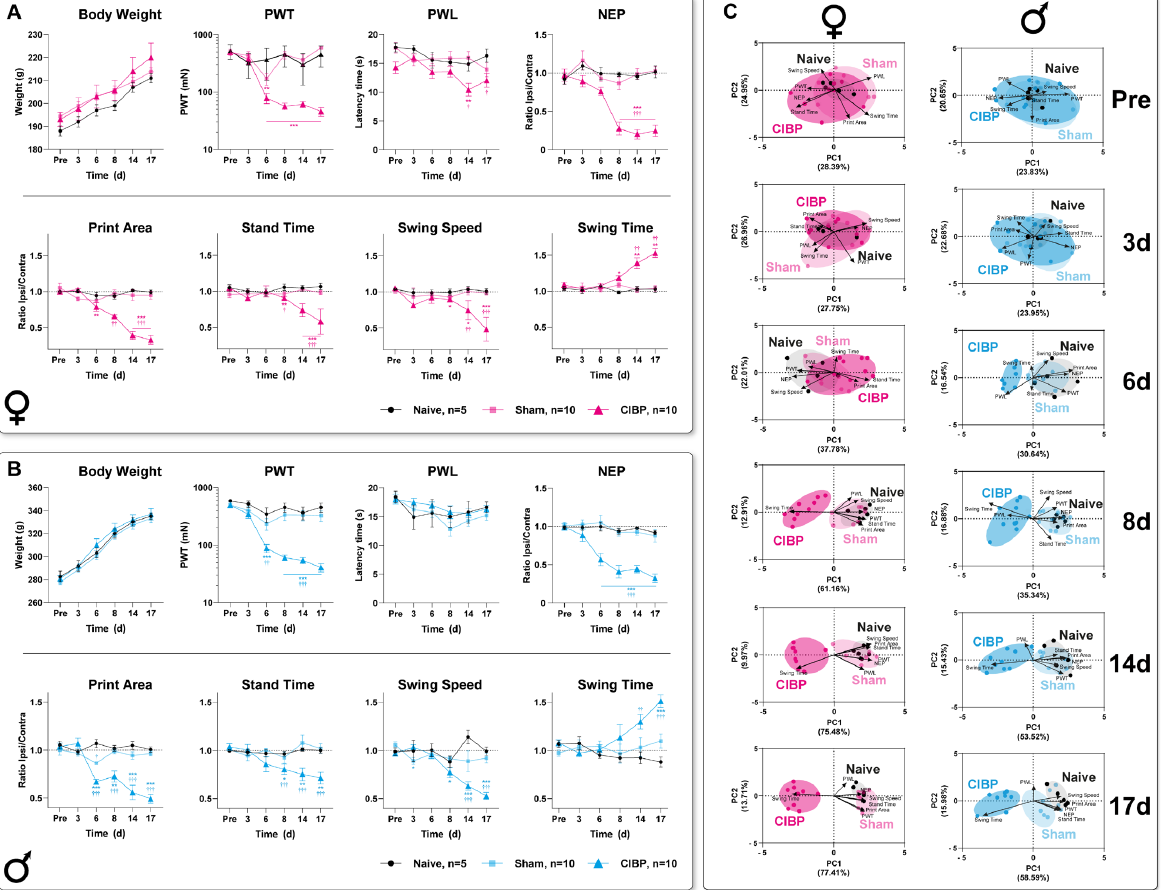
Figure 2. Bone cancer causes distinct pain-related behavior trajectories in both sexes of rats. ( A , B ) Trajectories of body weight and reflex-based withdrawal behavior, including paw withdrawal threshold to punctate mechanical stimuli (PWT), latency times to radiant heat stimuli (PWL), non-evoked pain-related behavior (NEP), and two static (print area, stand time) and two dynamic (swing speed, swing time) parameters of gait pattern analysis were determined in naïve, sham, and CIBP female ( A ) and male ( B ) rats. PWT was significantly decreased 6 d after cell inoculation in both sexes, and up to 17 d in CIBP rats. PWL was unaffected in CIBP males but significantly decreased in CIBP female rats at 14 d (to pre-value) and 17 d (to naïve). Assessment of the contralateral and ipsilateral hind-paw print area at rest revealed a non-evoked pain-related behavior (NEP) from 6 d in males and 8 d in females until 17 d, which was expressed by guarding behavior of the tumor-bearing hindlimb. Significant reduction to pre-value and naïve rats of print area, stand time, and swing speed combined with increased swing time, starting from 8 d in CIBP rats of both sexes, indicated an antalgic gait pattern. ( C ) Principal component analysis (PCA) of multimodal behavioral data was applied to identify a CIBP-induced phenotype in a time-dependent manner. Significant group segregation was determined at 6 d for CIBP males and 8 d for CIBP females. The results are expressed as mean ± SEM. Two-way ANOVA (repeated measures based on GLM) followed by Dunnett’s multiple comparison test. * for comparison to Pre; p -values: * ≤ 0.05, ** ≤ 0.01, *** ≤ 0.001. † for comparison to sham; p -values: † ≤ 0.05, †† ≤ 0.01, ††† ≤ 0.001. The PC components were selected to determine the eigenvalues. MANOVA was used for cluster analysis in PCA (see Supplementary Table S1). Black = Naïve rats, Light magenta = Female sham rats, Magenta = Female CIBP rats, Light cyan = Male cham rats, Cyan = Male CIBP